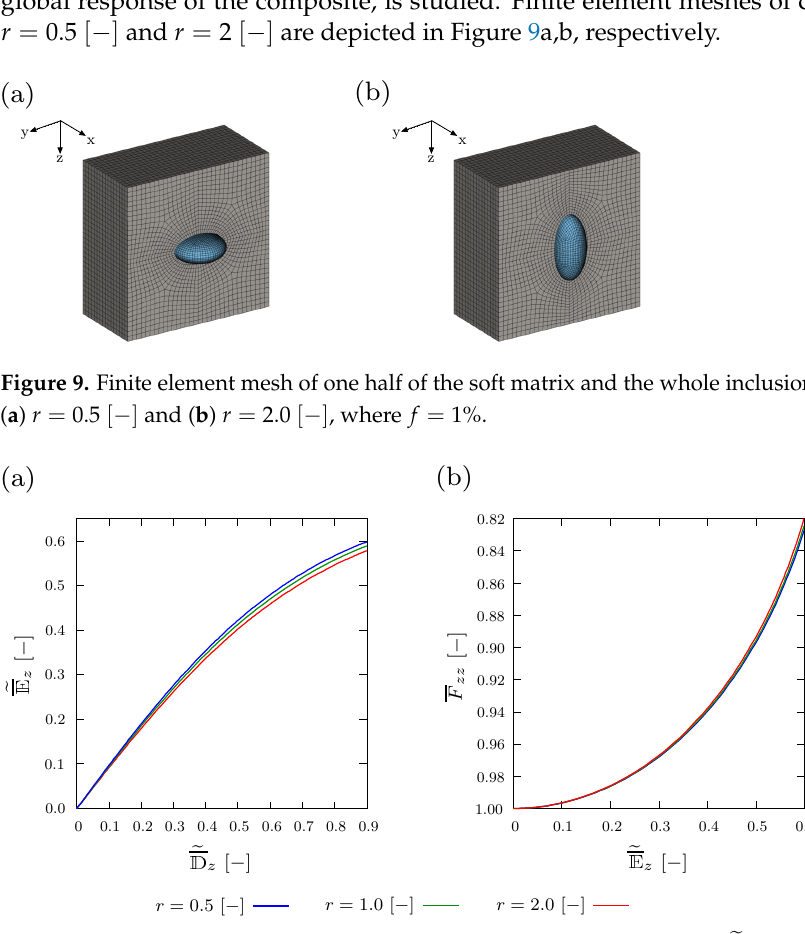
Figure 10. Plot of ( a ) averaged and normalized electric displacement (cid:101) D z [ − ] and ( b ) averaged deformation F zz [ − ] versus averaged and normalized electric field (cid:101) E z [ − ] with different aspect ratios r [ − ] of the inclusion, where f = 1% and θ init = 298